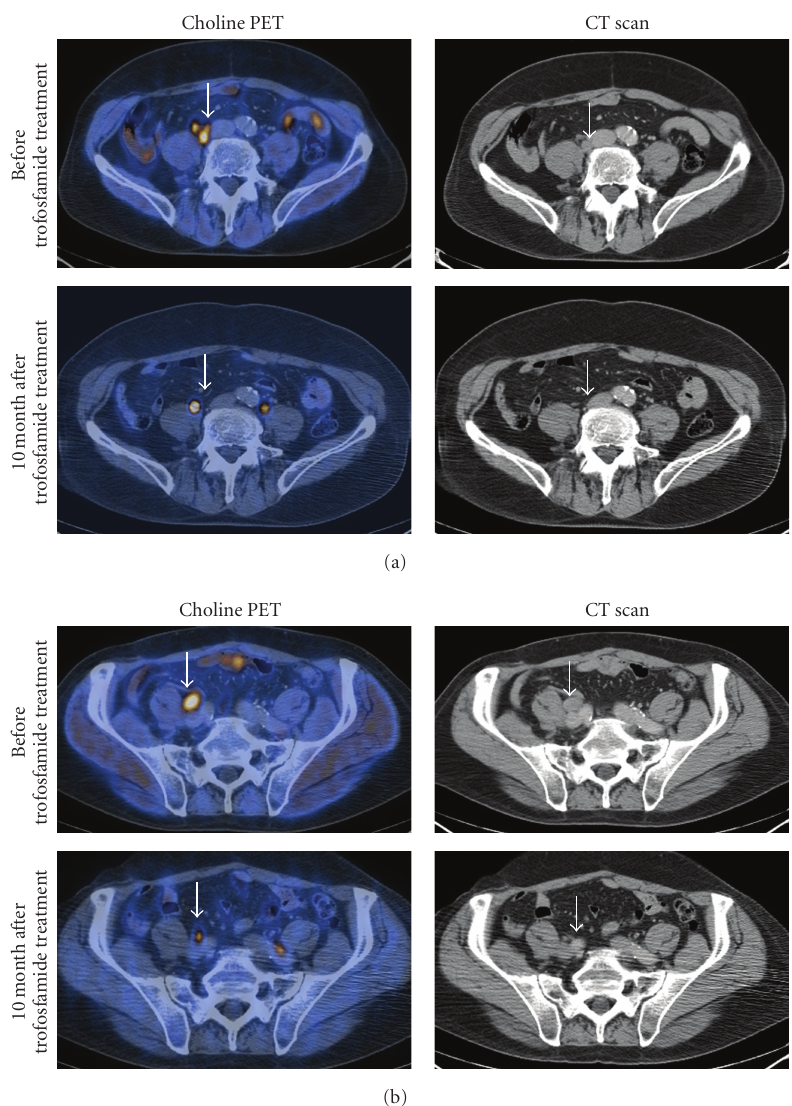
Figure 2: (a) and (b) show exemplarily the regression of a lymph node metastasis, demonstrated by choline-PET-CT before and 10 months after treatment with